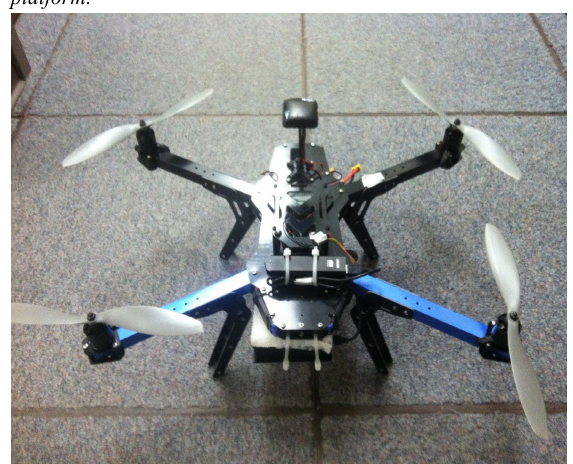
Figure 2. Close-up image of the top of the 3D Robotics Quad